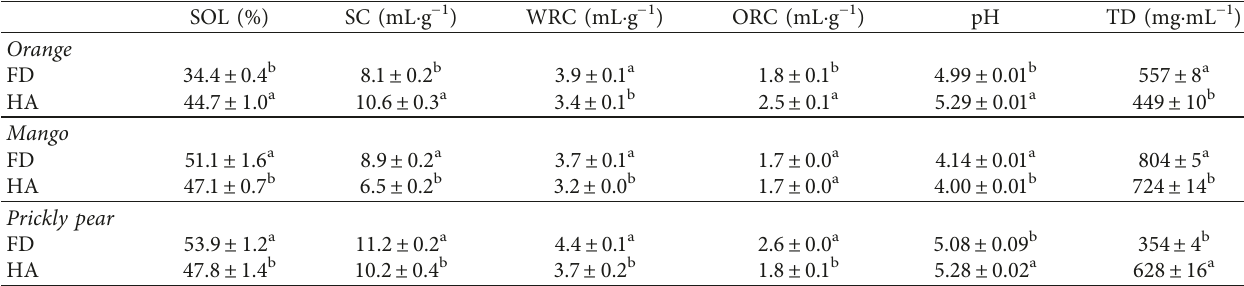
Table 4: Physicochemical properties of dietary fibre concentrates from orange, mango, and prickly pear peels freeze-dried (FD) and convective hot air-dried (HA).